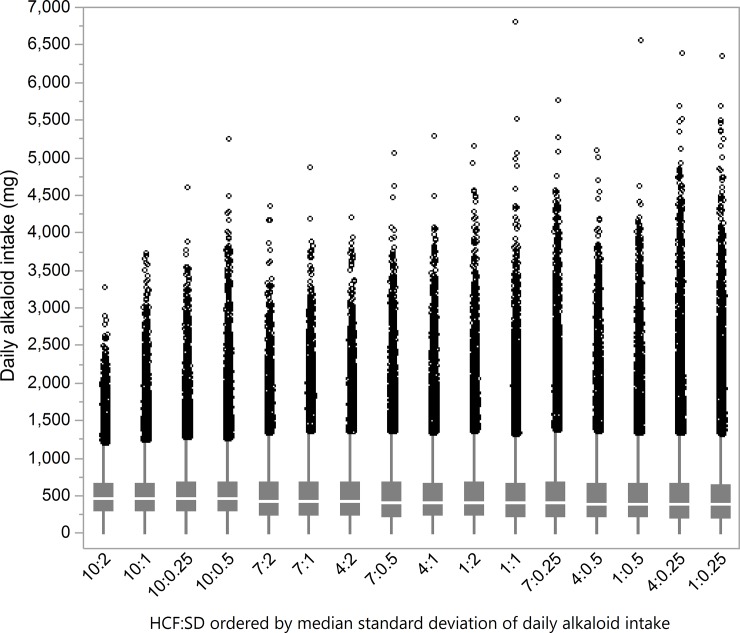
Box plots of distribution of individual daily alkaloid intake (mg; n = 1.88 • 105).From 30 model runs for each combination of herd-cohesion factor (HCF) and stocking-density (SD), ordered by median standard deviation of daily alkaloid intake, with outliers as jittered circles.